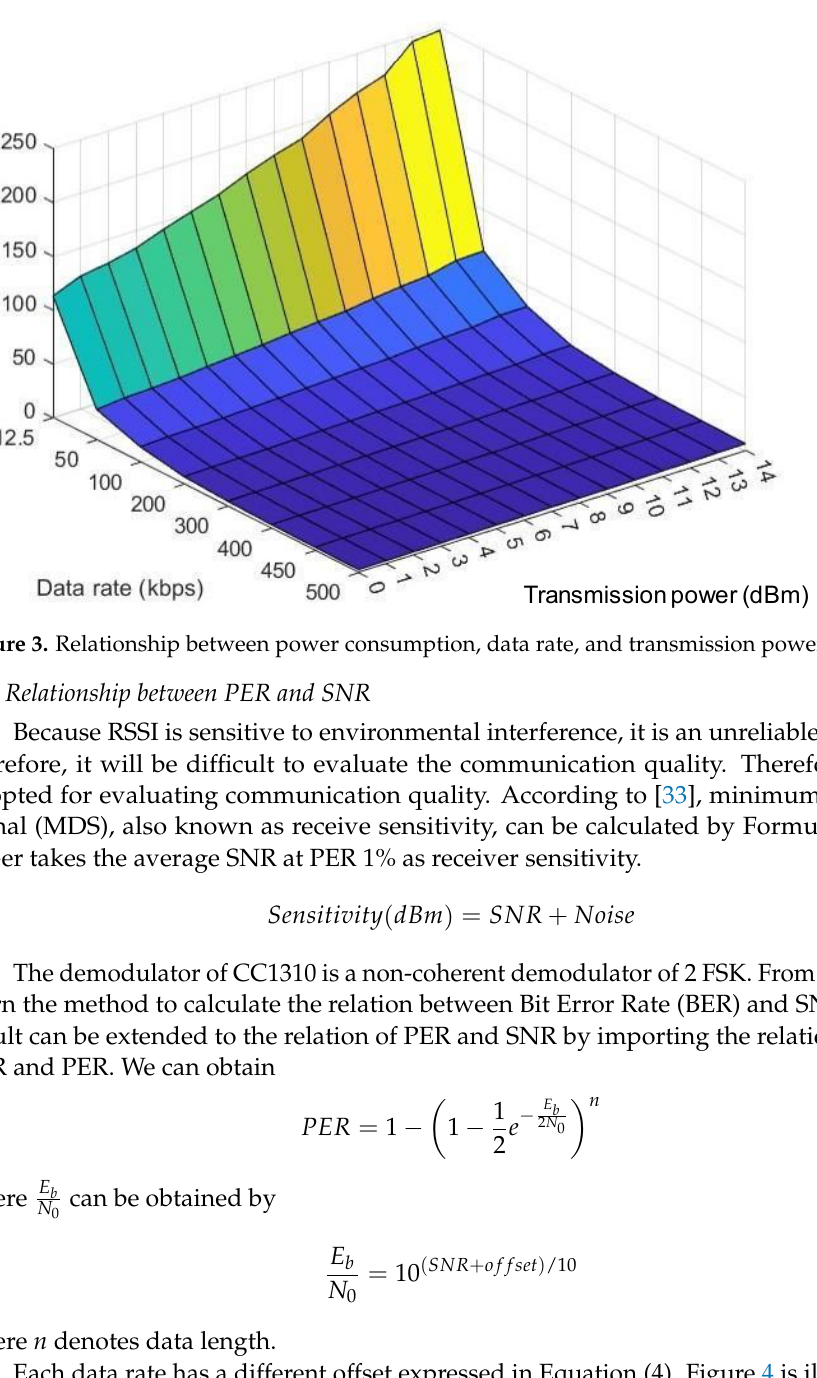
Table 2. Average current.